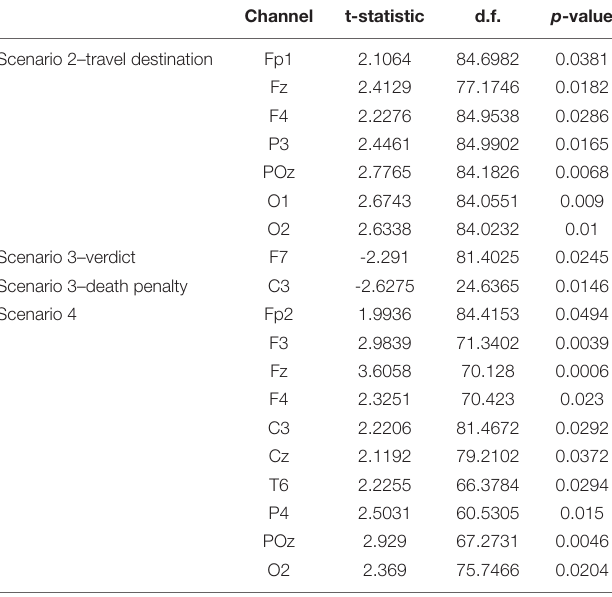
TABLE 4 | Sample sizes of unanimous and non-unanimous groups by scenario. Always